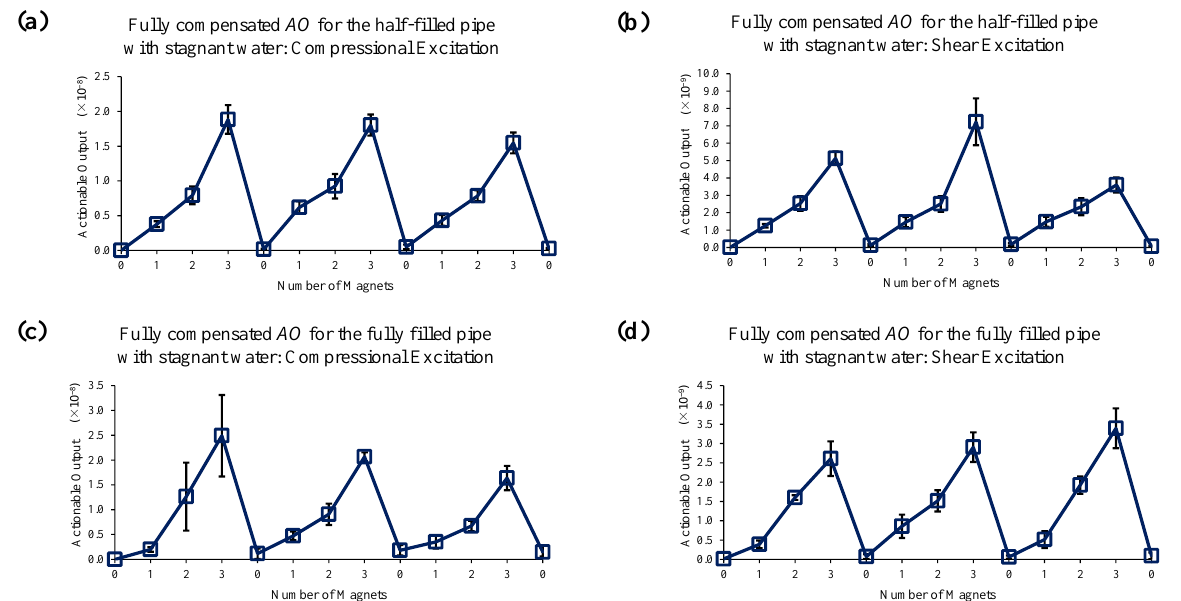
number of magnet perturbations. One can conclude that the accuracy and sensitivity of Figure 12. Changes in AO with the different number of magnet perturbations for the half-filled pipe with ( a ) compressional and ( b ) shear excitations; and the fully filled pipe with ( c ) compressional and ( d ) shear excitations. In this case, only the 1st EOC compensation method is applied.